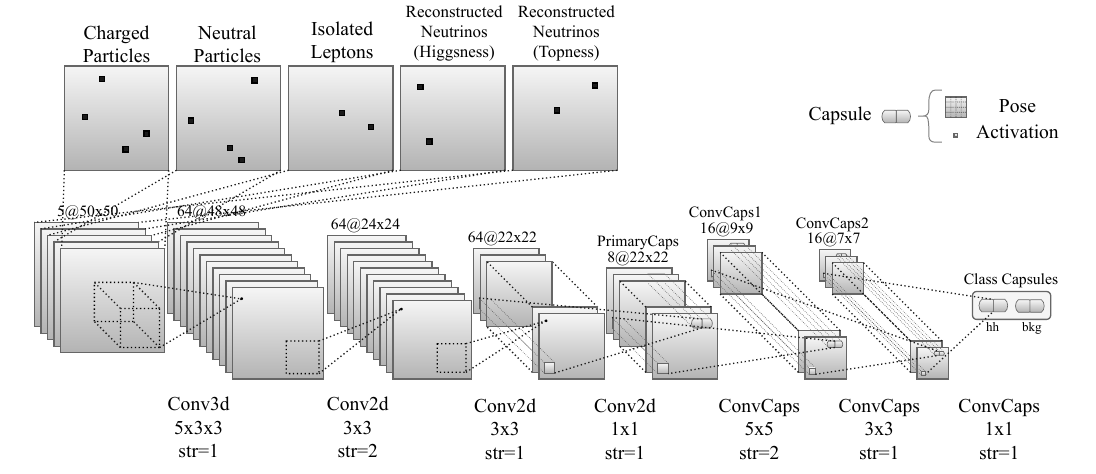
Figure 9 . A schematic architecture of the matrix capsule network model (Matrix CapsNet) used in this